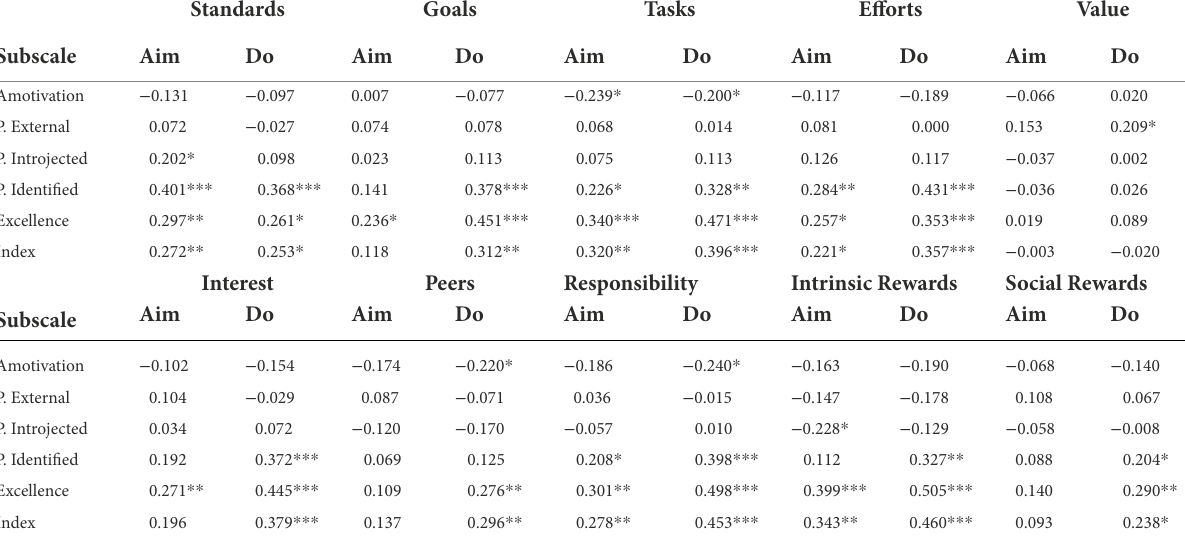
TABLE 6 Correlations between the MPSES and the Motivation to Achieve Academically Scale, Study